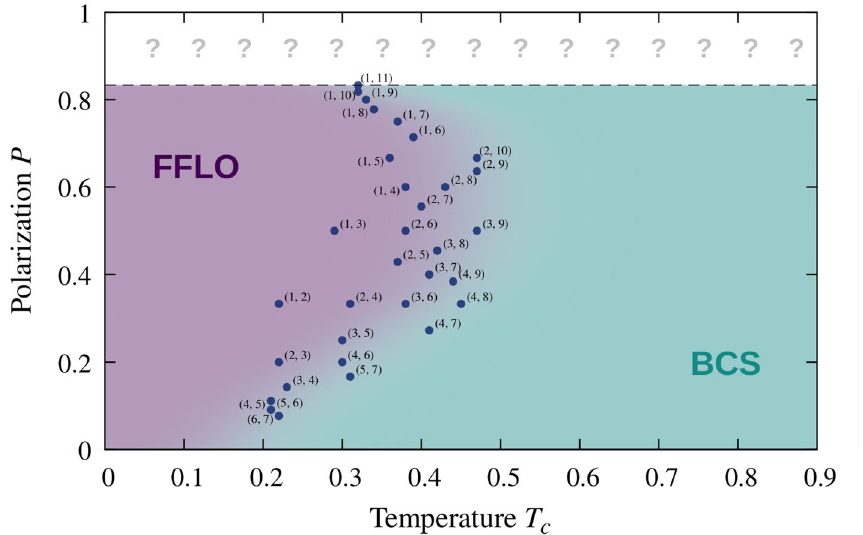
3 . Different points = − , N ) indicated in parenthesis. Apart from the ↑ ↓